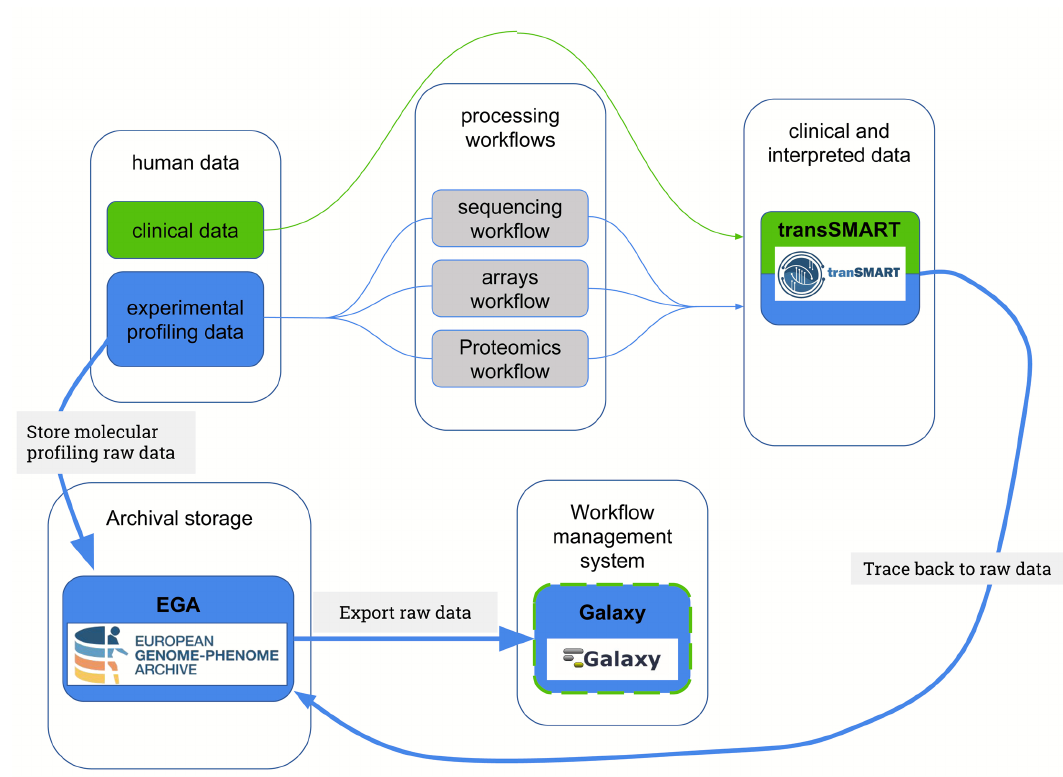
Figure 3. A designed data ecosystem based on TraIT: interpreted data together with clinical data can be explored in tranSMART, subsequently tracked back to the raw data in EGA, and finally, raw data in EGA can be imported to Galaxy, where workflows can be applied to the raw data. The blue arrows in this figure depict the connections implemented as a proof of concept by the current work.